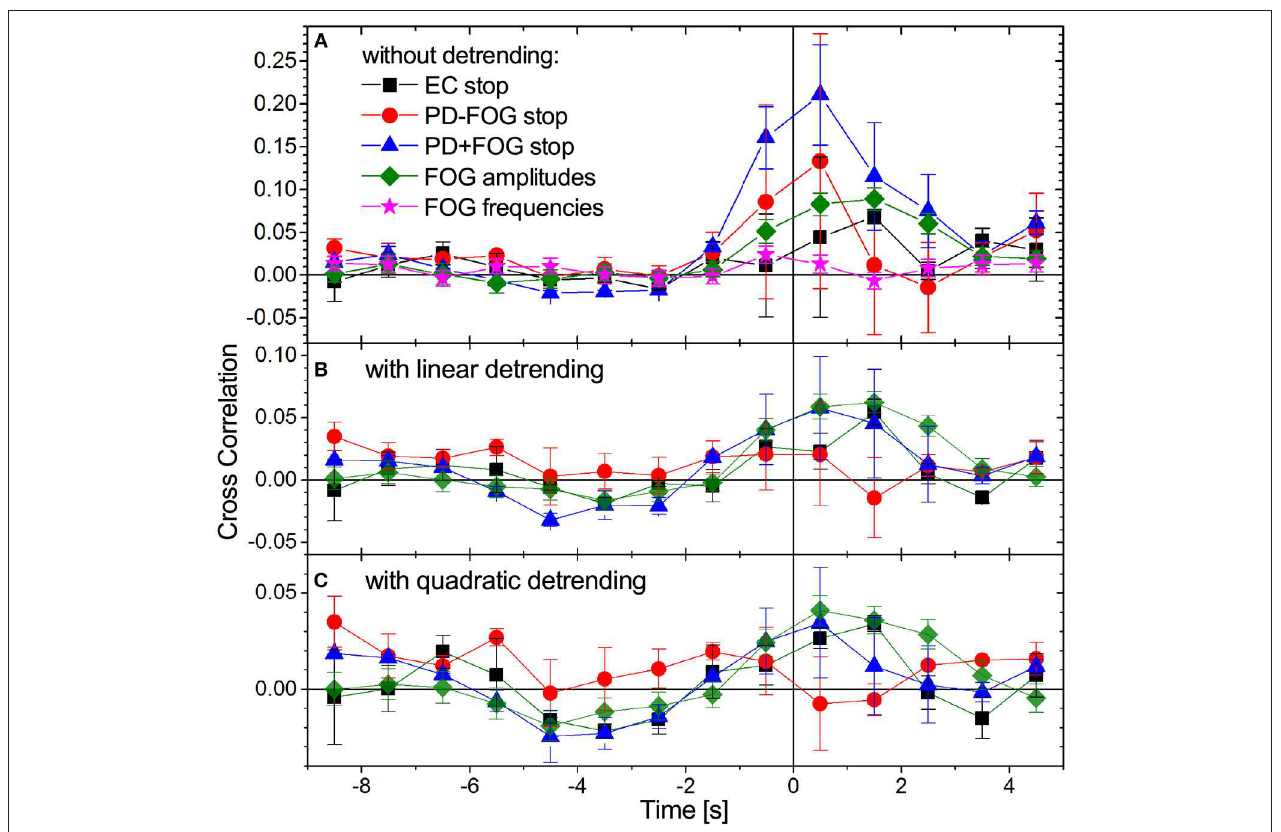
FIGURE 5 | (Color online) Time-dependent cross-correlations between EMG amplitudes and EEG amplitudes during gait (time: –9 to 0 s) followed by a commanded stop or a FOG episode (time: 0 to +5 s). Data for all pairs of EMG amplitude signals (both legs and both muscles) and all EEG amplitude signals (four bands, see caption of Figure 4 ) have been averaged. The legend in (A) is valid for all panels showing results for stop episodes in all three groups of subjects and for FOG episodes in the PD+FOG group, (A) without detrending, (B) with linear detrending, and (C) with quadratic detrending (see Equation 3). The large drop in the cross-correlation curves for stop episodes after detrending (especially for PD+FOG) indicates that the pronounced maximum at the beginning of the stops is mainly caused by non-stationarities (nearly step-like trends) in the amplitude signals. However, the detrended cross-correlation curves for stop and FOG episodes in the PD+FOG group are not clearly different, since there is an overlap of their error bars at all time points. Error bars indicate standard errors of the means. We note that because we are considering 4-s windows in the cross correlation analysis, Equation (3), two data points appearing to the left (right) of the vertical line (time 0) are influenced by data originating from the right (left) of this line. Cross-correlations between EEG amplitudes and EMG frequencies do not change with transition to FOG as also shown in (A)